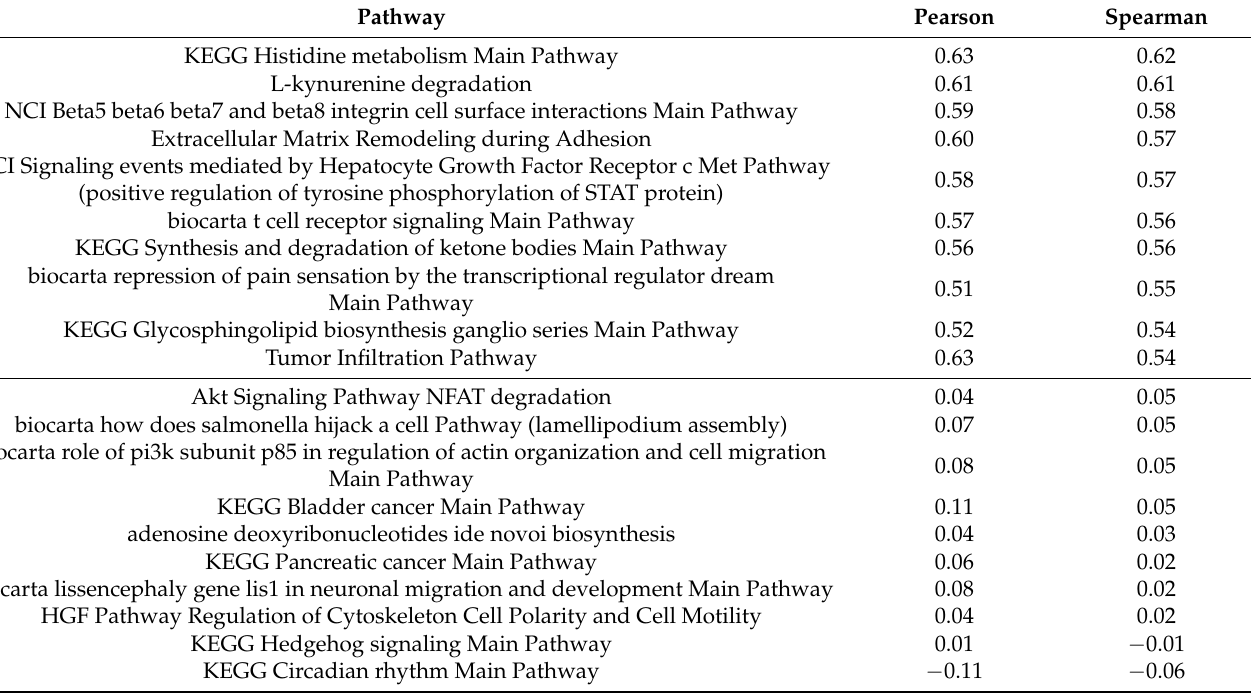
Table 6. “Top-10” of the most and the least correlated molecular pathways between RNA and protein expression levels calculated for Pancreatic Ductal Adenocarcinoma